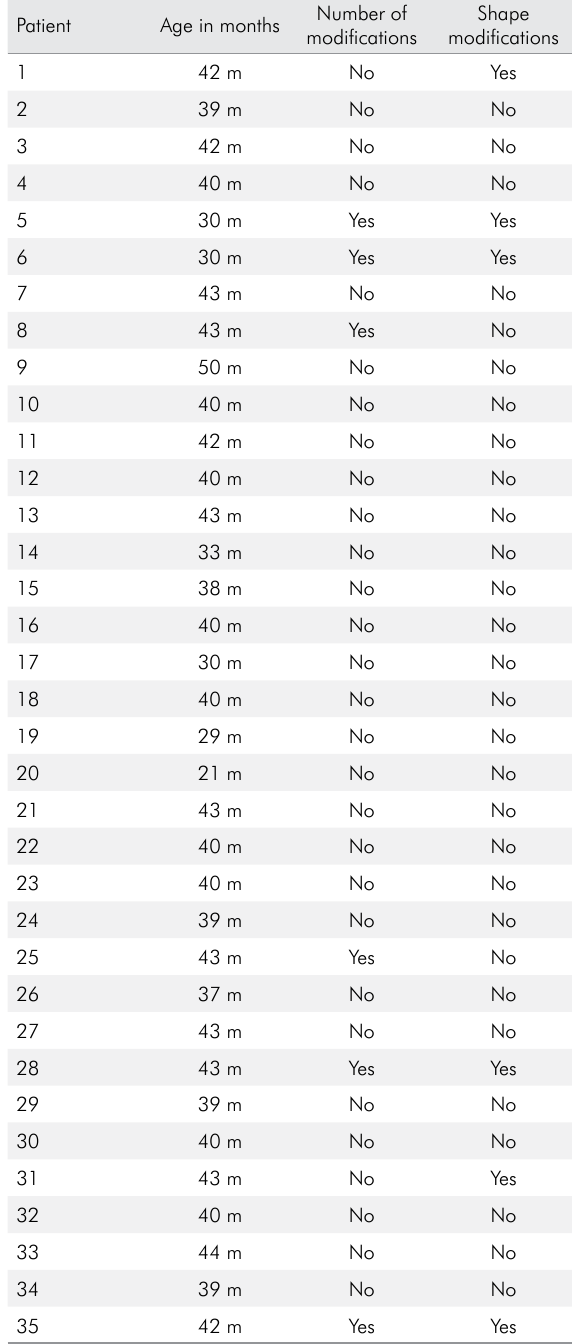
Table 1. List of patients and the presence of modifications